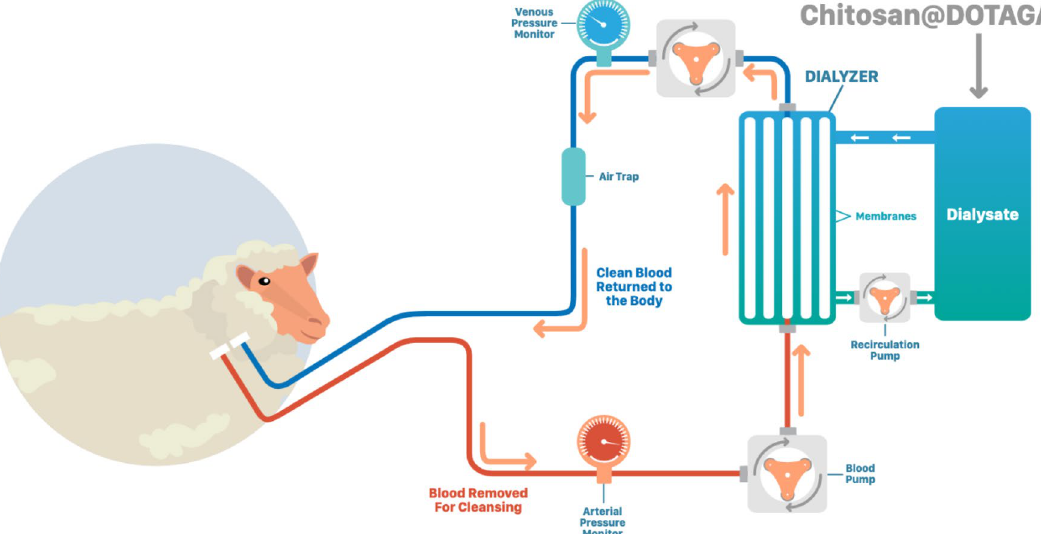
Figure 4. Schematic representation of the metallic extraction experiment on sheep using hemodialysis in recirculation conditions in presence of Chitosan@DOTAGA. Blood is purified by passage in dialysis membrane and metals are retained in the dialysate due to presence of Chitosan@DOTAGA. Two high cut-off membranes (Theralite and SepteX) are compared with standard dialyzer (POLYFLUX H6).